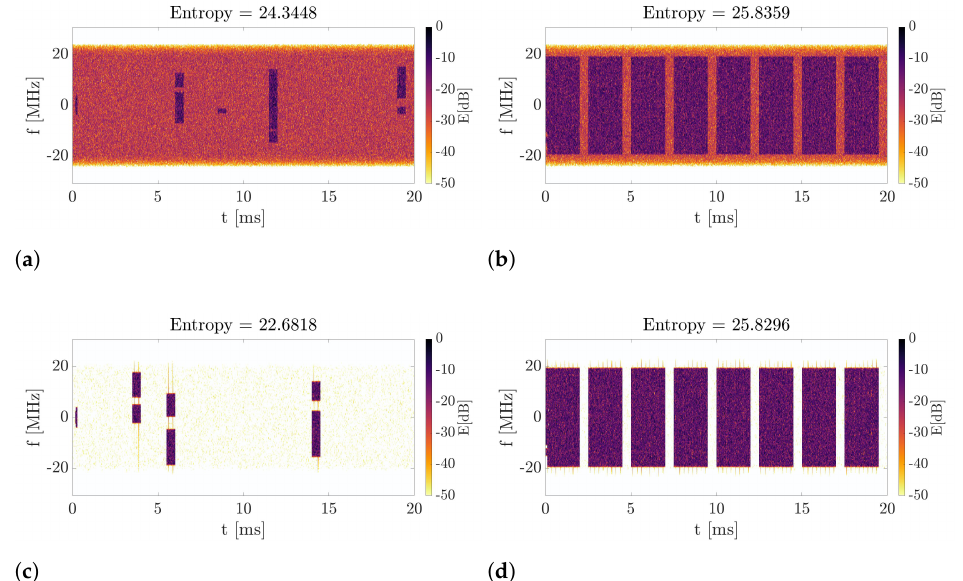
Figure 12. A comparison of the Rényi entropy value for different filling and SNR. ( a ) Spectrogram of the simulated 5G transmission with 5% allocated subcarriers and SNR = 10 dB. ( b ) Spectrogram of the simulated 5G transmission with 100% allocated subcarriers and SNR = 10 dB. ( c ) Spectrogram of the simulated 5G transmission with 5% allocated subcarriers and SNR = 40 dB. ( d ) Spectrogram of the simulated 5G transmission with 100% allocated subcarriers and SNR = 40